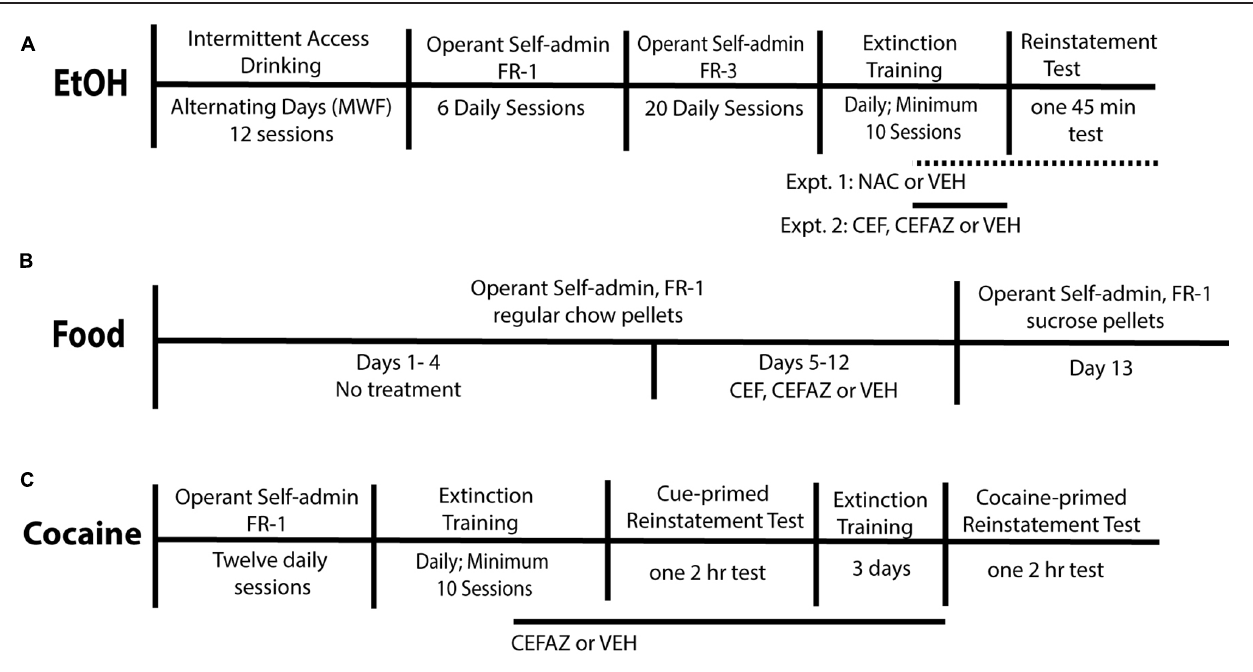
FIGURE 1 | Experimental Methods. (A) Timeline of the experimental procedure for Experiments 1 and 2. All animals were trained